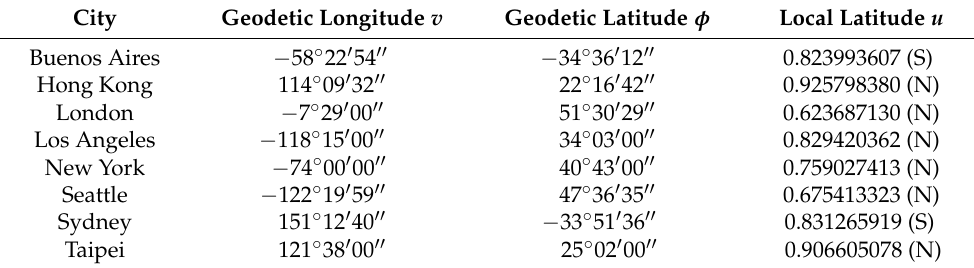
Table 1. Geodetic and local coordinates of cities on the important air routes on the Earth’s surface. City Geodetic Longitude v Geodetic Latitude φ Local Latitude u